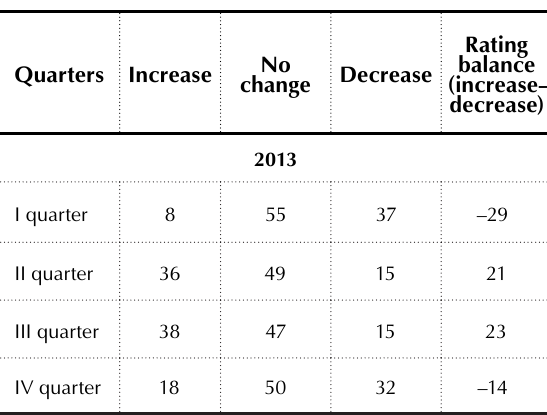
Table 2 . Percentage of demand and its quarterly